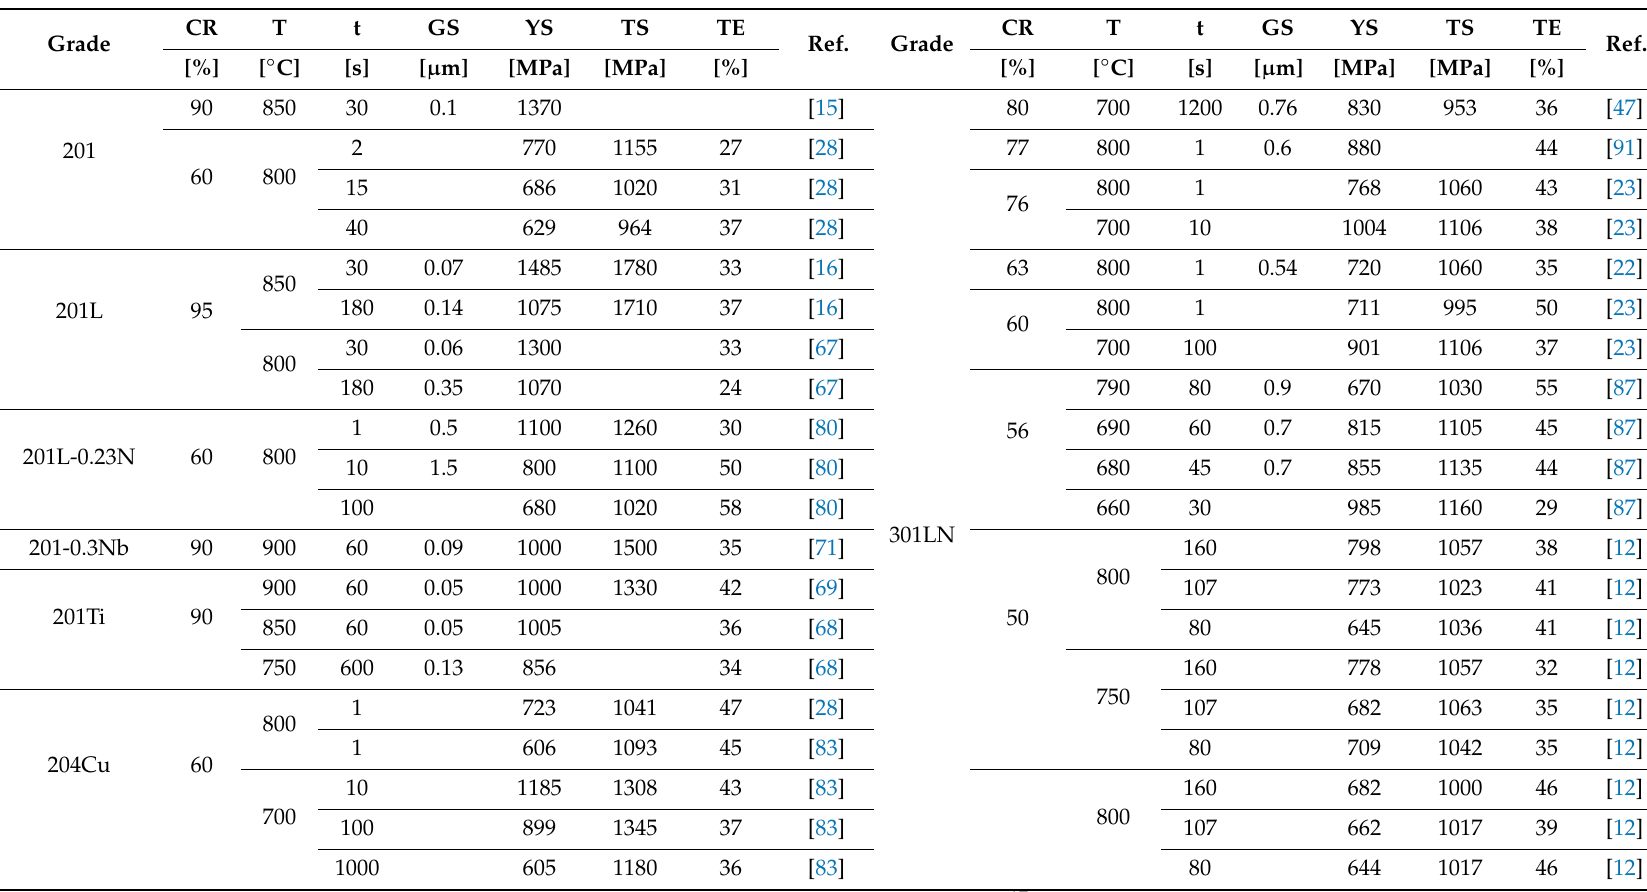
Table 2. Examples of grain sizes and mechanical properties achieved in reversion treatments of Cr-Mn, Cr-Ni and some special austenitic stainless steels.